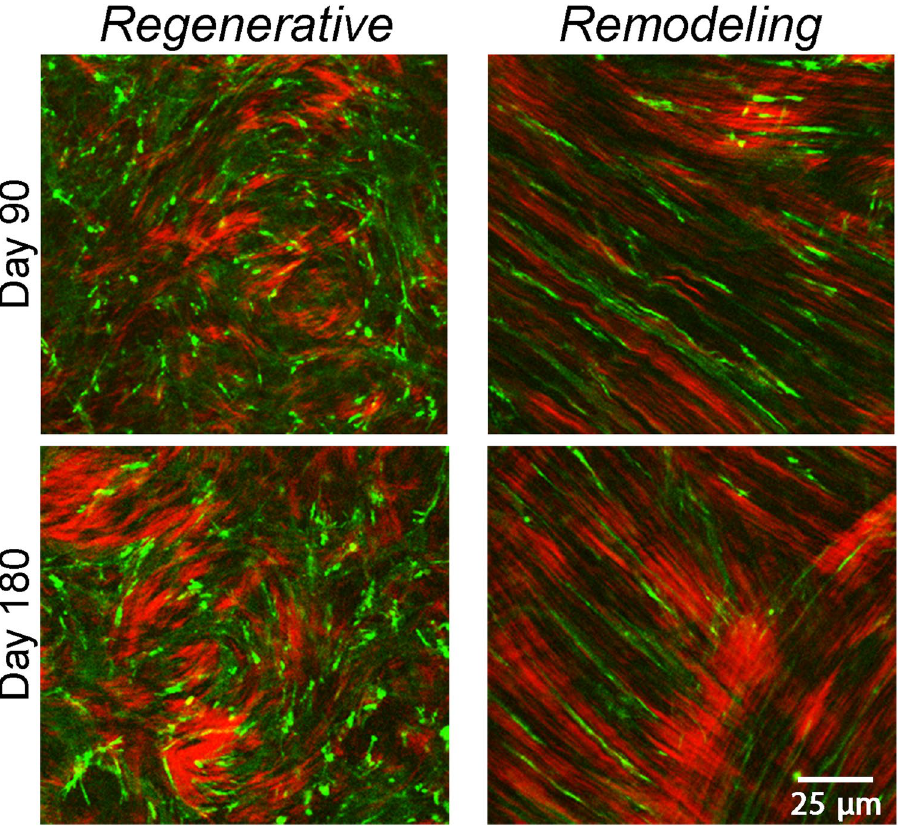
Figure 6. High magnification SHG and multiphoton image overlays showing association between collagen (shown in red) and F-actin (shown in green) during stromal remodeling and regeneration. Note that the pattern of punctate F-actin labeling is highly correlated with the collagen, suggesting cell-matrix